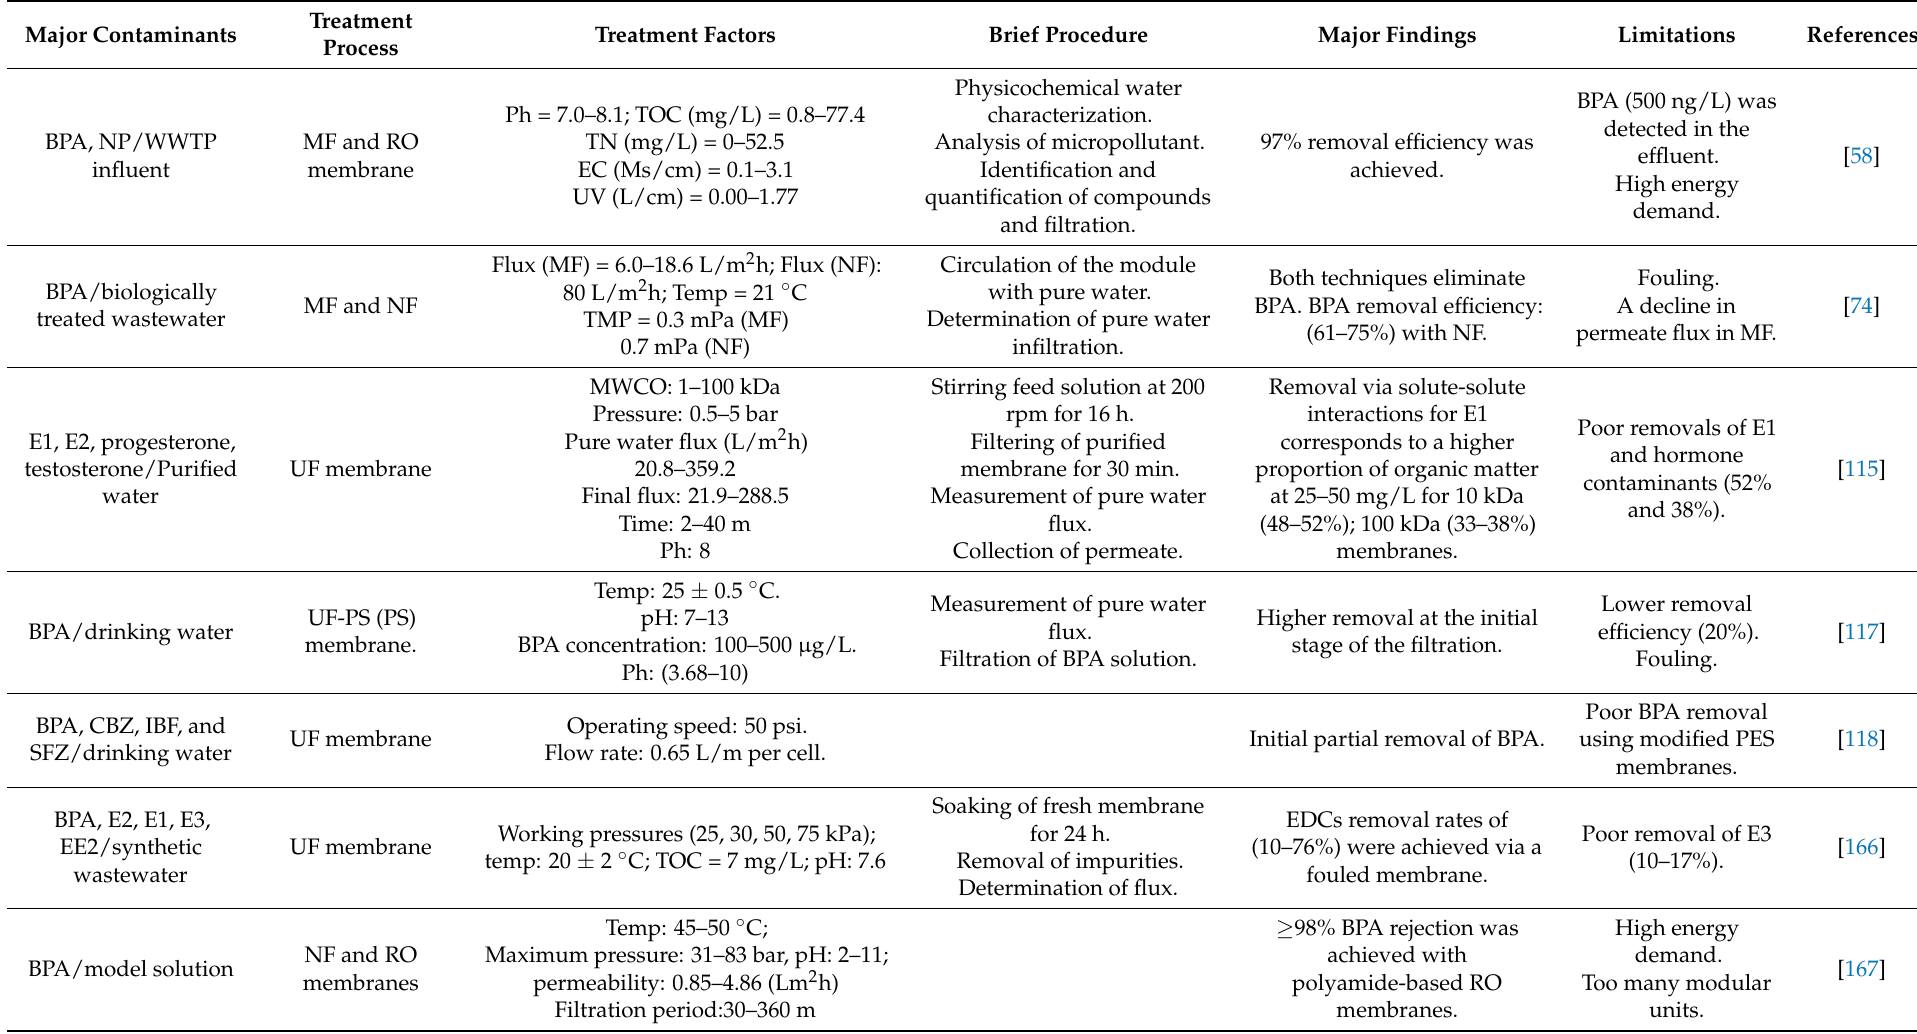
Table 4. Rejections of EDCs by